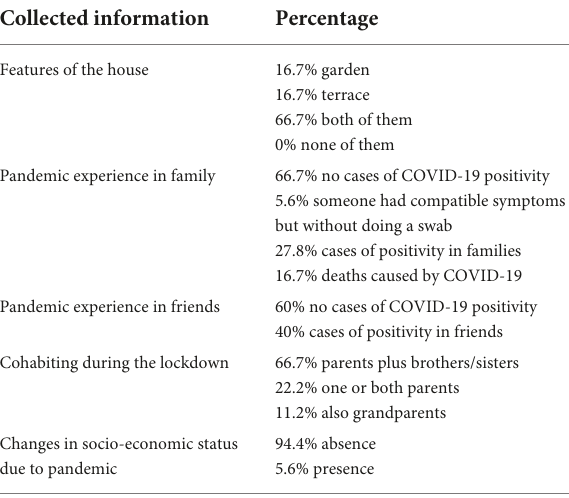
TABLE 2 Sample description of COVID-19 related